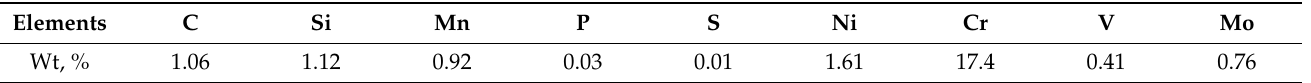
Table 2. Elemental composition of refiner